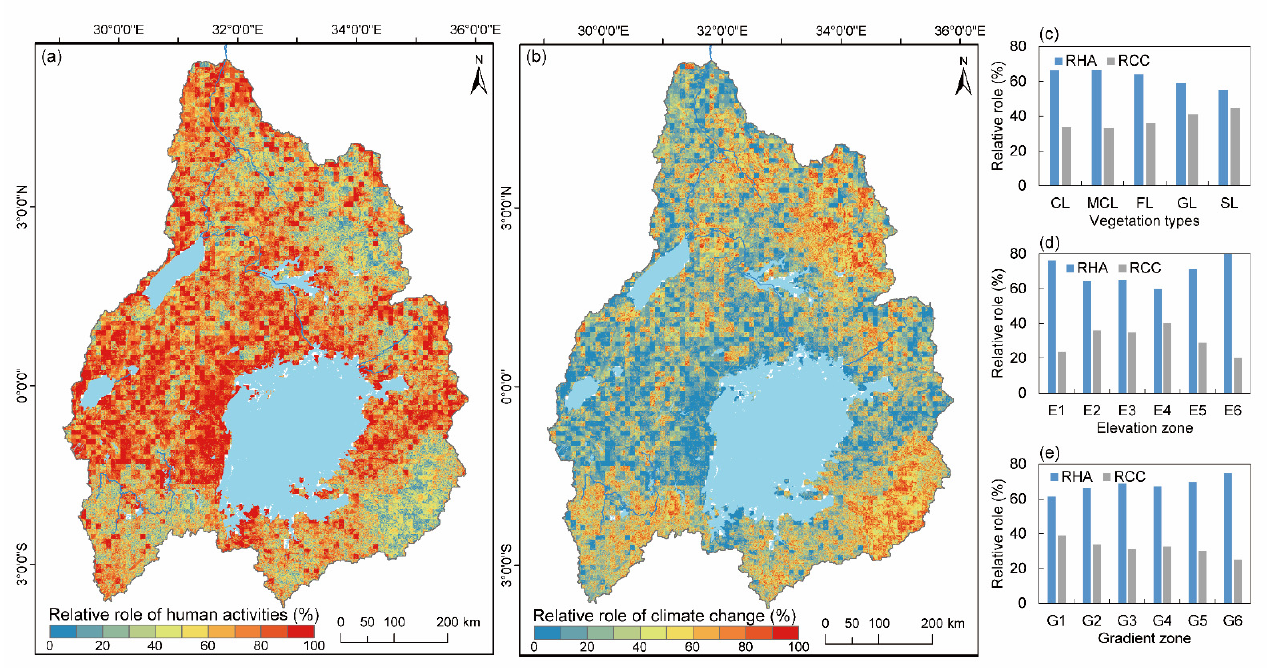
Figure 9. Relative role of human activities and climate change. ( a ) The relative role of human activities. ( b ) The relative role of climate change. ( c ) The relative role of different vegetation types. ( d ) The relative role of different elevation zones. ( e ) The relative role of different gradient zones. Note: RHA is the relative role of human activities, and RCC is the relative role of climate change.